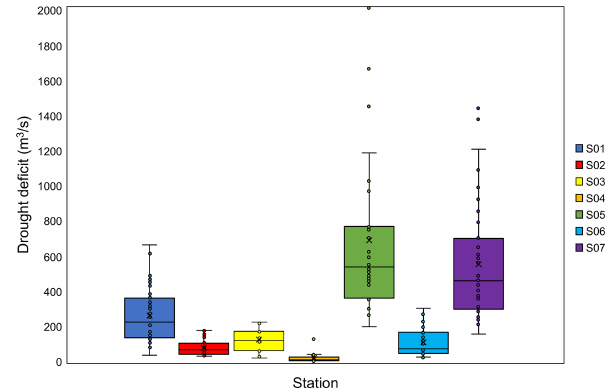
Figure 9. Drought deficit for all